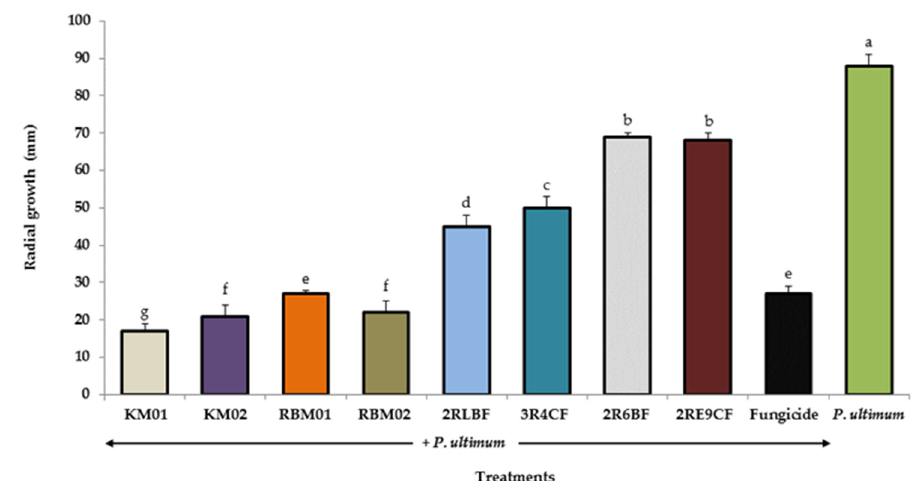
Figure 1. Effect of marine bacteria on the radial growth of Pythium ultimum . The bacteria are Stenotrophomonas rhizophila (KM01 and KM02), Bacillus subtilis (RBM01 and RBM02), B. amyloliquefaciens (2RLBF and 3R4CF), and Pseudomonas spp. (2R6BF and 2RE9CF). Data are shown as the mean ± standard deviation (SD) ( n = 100). Columns with different letters were significantly different according to Tukey’s test ( p < 0.05).